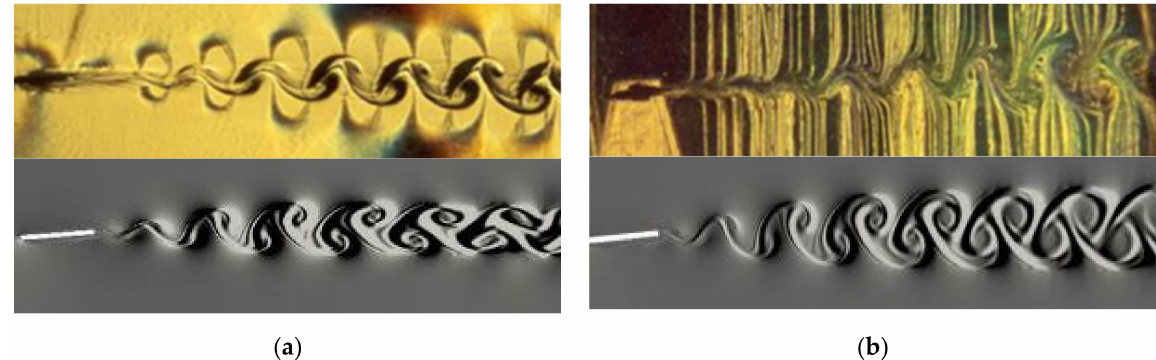
Figure 9. Schlieren (upper part of the images) and calculated (lower one) vortex flow patterns past a uniformly moving tilted plate L = 2.5 cm, α = 16 ◦ , U = 4.3 cm/s: ( a )— T b = 7.6 s, N = 0.83 s − 1 , ( b )— T b = 6.3 · 10 5 s, N = 10 − 5 s − 1 , vertical striations in the Schlieren image ( b ) are density markers which visualize the flow structure for the case of homogenous